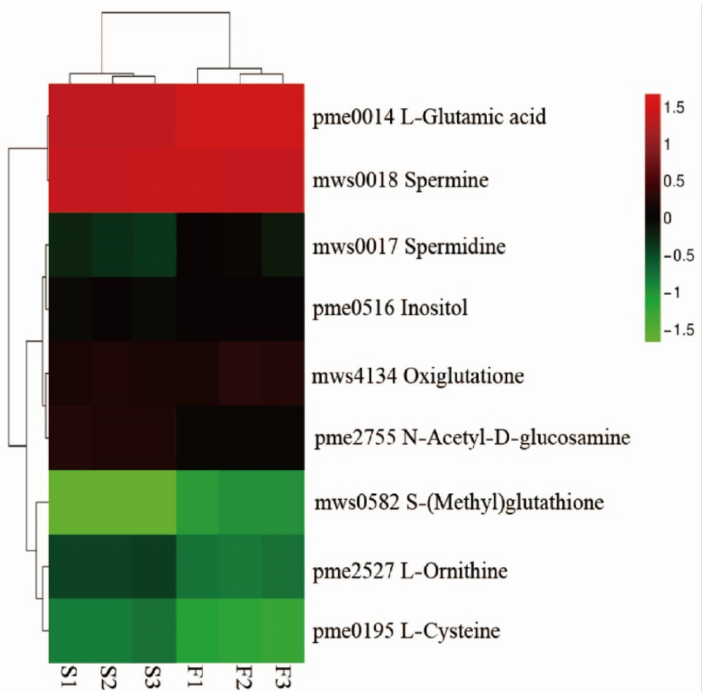
Figure 8. Cluster heat map of GSH-related DEMs between F and S cell lines of Korean